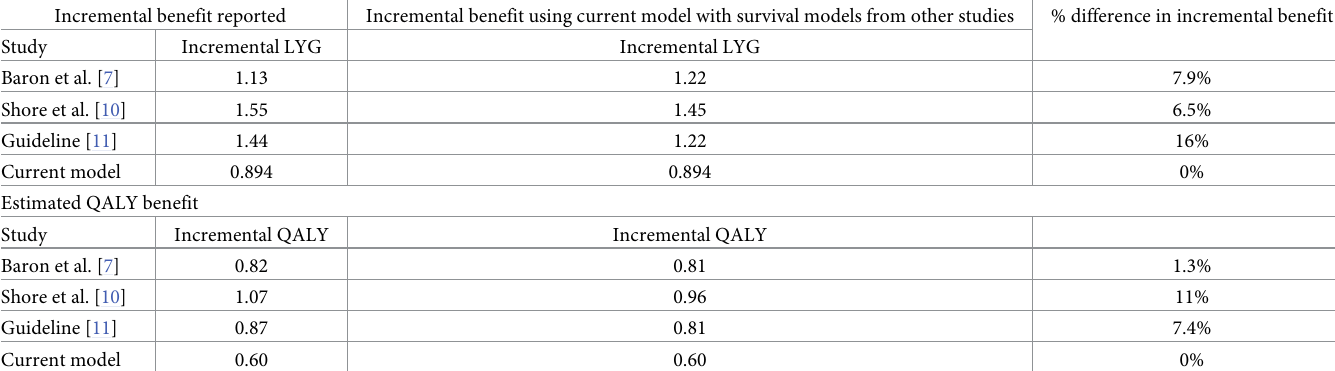
Table 2. Impact of other CE study’s survival models on ICER output from the current model.